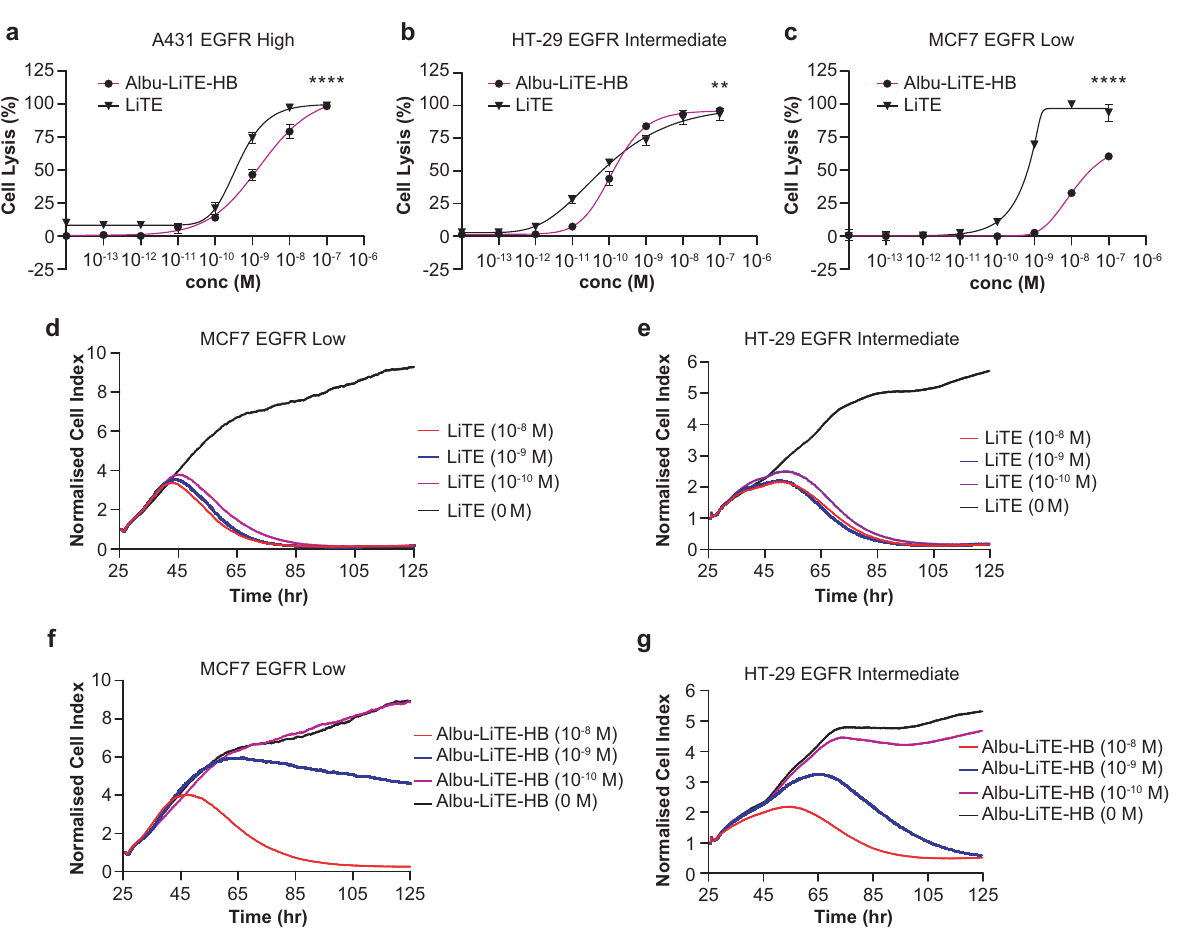
Fig. 6 Lactate dehydrogenase (LDH) and real-time cytotoxicity assays of bispeci fi c T-cell-activated cell killing. The effect of increasing concentration of the LiTE (triangle) versus the Albu-LiTE-HB (circle) construct was evaluated using an LDH endpoint assay ( a – c ). a T-cell-mediated cell killing of high EGFR expressing A431 cells with increasing protein concentrations. b T-cell-mediated cell killing of intermediate EGFR expressing HT-29 cells with increasing protein concentrations. c T-cell-mediated cell killing of low EGFR expressing MCF7 cells with increasing protein concentrations. For real-time assessment of cell killing, target cells were grown for 25 h and LiTE or Albu-LiTE-HB (10 − 8 M; red line, 10 − 9 M; blue line or 10 − 10 M; purple line) were added together with human peripheral blood mononuclear cells (PBMCs) and the cell index measured every 10 min to monitor cell density ( d – g ). d Effect on MCF7 EGFR low cell density mixed with PBMCs and various concentrations of LiTE from 24 h after addition compared to the negative control (0 M; black line). e Effect on HT-29 EGFR intermediate cell density mixed with PBMCs and various concentrations of LiTE from 24 h after addition compared to the negative control (0 M; black line). f Effect on MCF7 EGFR low cell density mixed with PBMCs and various concentrations of Albu-LiTE from 24 h after addition to the negative control (0 M; black line). g Effect on HT-29 EGFR intermediate cell density with various concentrations of Albu-LiTE-HB from 24 h after addition compared to the negative control (0 M; black line). Statistical analysis was made in GraphPad prism using two-way ANOVA,** p < 0.005, **** p < 0.0001. Error bars represent standard